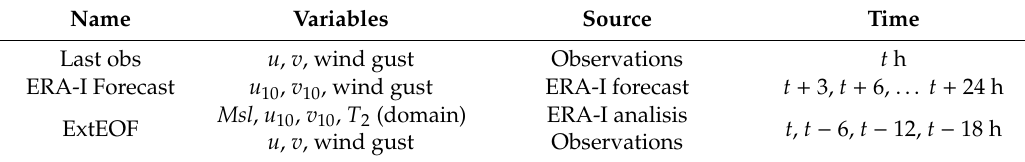
Table 2. Summary description of the statistical model raw inputs